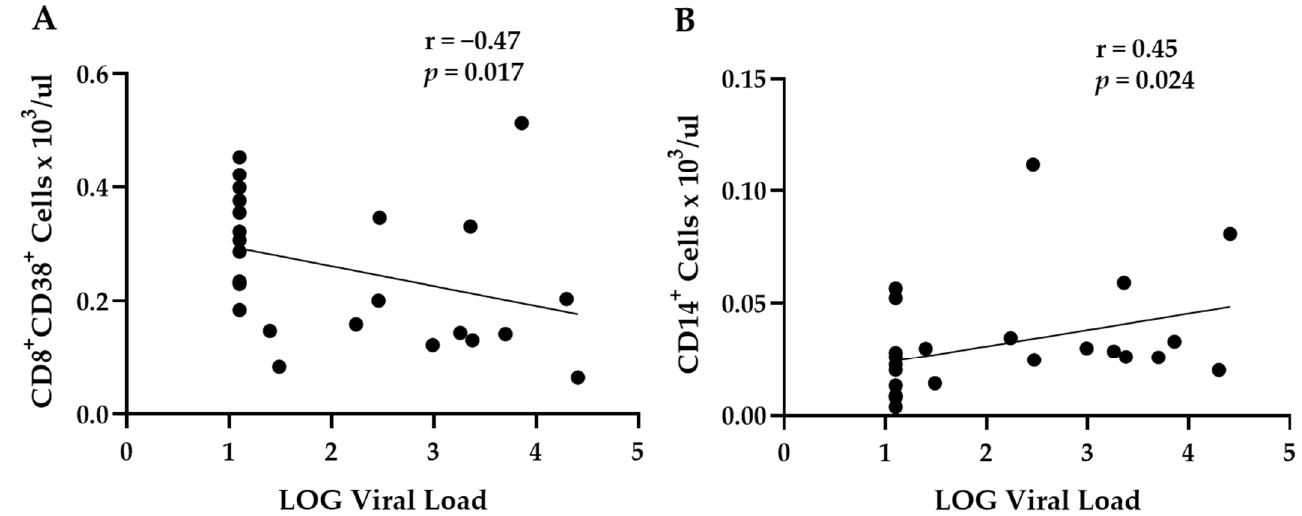
Figure 4. Spearman correlations of viral load with immune cell populations. ( A ) Viral load had a significant negative correlation with activated CD8 + CD38 + T cell counts. ( B ) Viral load had a positive significant correlation with CD14 + monocyte counts. A LOG value of 1.1 was used for SIV-infected samples that had undetected virus. Vehicle (VEH)/sham surgery (SHAM) ( n = 8), VEH/ovariectomy (OVX) ( n = 7), chronic binge alcohol (CBA)/SHAM ( n = 7), and CBA/OVX ( n = 7). Two-way ANOVA and Tukey’s multiple comparison test. p ≤ 0.05.